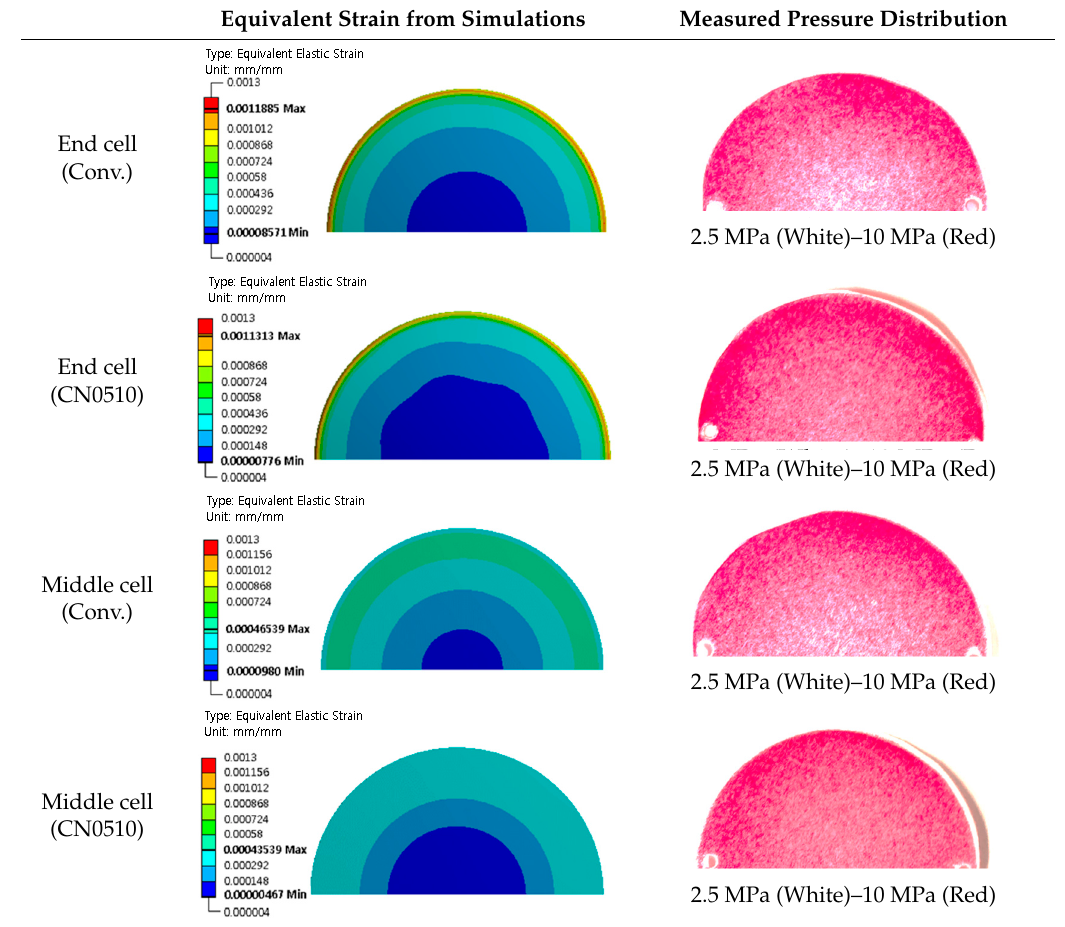
Table 5. Comparison of the simulated equivalent-strain distribution with the experimental pressure distribution, using the circular end plates of the dummy-cell stack.